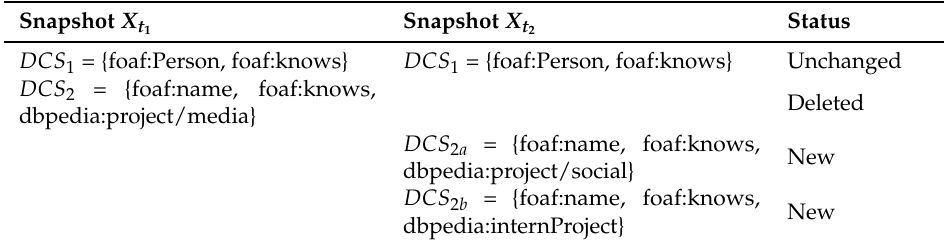
Table 1. Rate of change in snapshots using Dynamic Characteristic Set